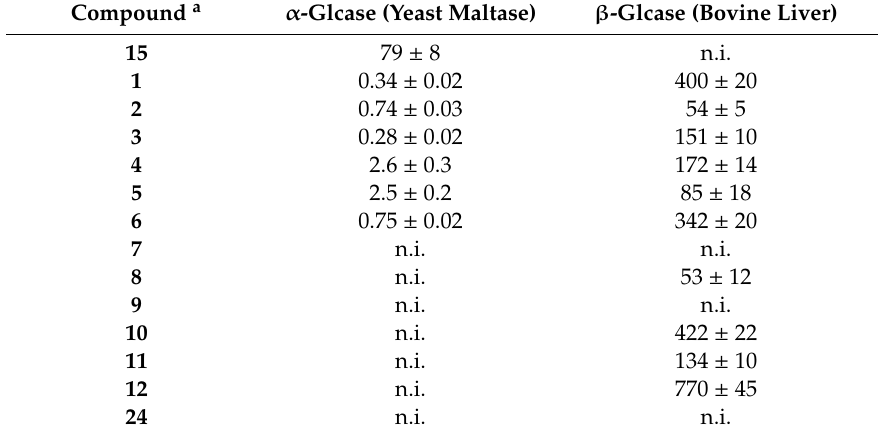
Table 1. Glycosidase inhibitory activities ( K i , µ M) of the new ONJ ( 1 – 6 , 15 ) and OGJ ( 7 – 12 , 24 ) C -glycoside derivatives. Values represent the mean ± SD (three independent determinations). Inhibition was competitive in all cases. Compound a α -Glcase (Yeast Maltase) β -Glcase (Bovine